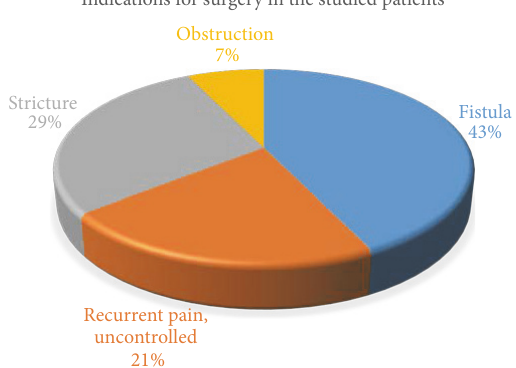
Figure 1: Indications for surgery in the study’s sampled